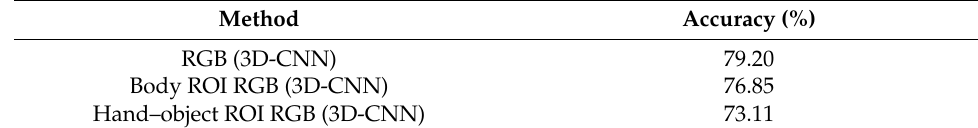
Table 3. ROI-based behavior recognition accuracy (CS).